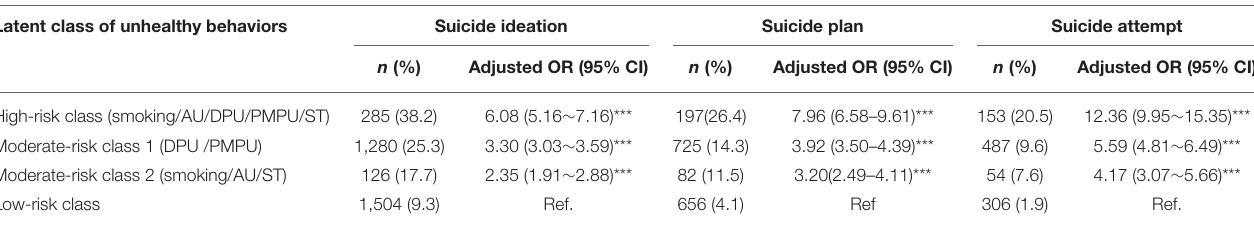
TABLE 4 | Associations of SBs and patterns of unhealthy behaviors in Chinese